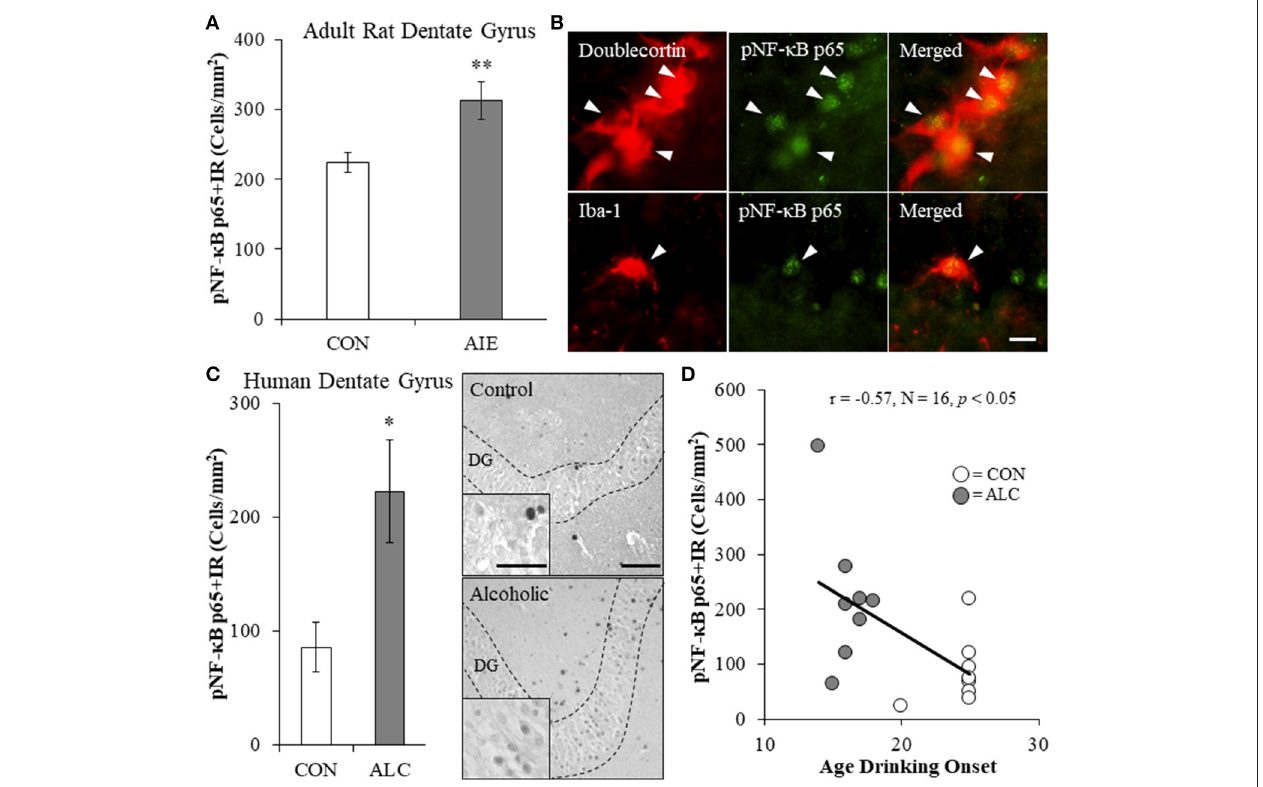
FIGURE 2 | Increased expression of the proinflammatory transcription factor nuclear factor kappa-light-chain-enhancer of activated B cells p65 (phosphorylated [pNF- κ B p65]) in the hippocampal dentate gyrus of adolescent intermittent ethanol (AIE)-treated adult rats and post-mortem human alcoholics. (A) Modified unbiased stereological quantification of pNF- κ B p65 + IR cells revealed a 40% ( ± 12%) increase in the adult (P80) hippocampal dentate gyrus of AIE-treated animals, relative to CONs. (B) High magnification photomicrographs of pNF- κ B p65 (green) colocalization with the immature neuron marker doublecortin and the microglial marker Iba-1 (red) in the hippocampal granule cell layer of an AIE-treated rat. White arrowheads indicate pNF- κ B p65 + IR cells that colocalized with a cellular marker. Scale bar = 10 µ m. (C) pNF- κ B p65 + IR was increased in the post-mortem human alcoholic (ALC) hippocampal dentate gyrus ( n = 8), relative to moderate drinking controls (CON; n = 8). Representative photomicrographs of pNF- κ B p65 + IR in a moderate drinking control and alcoholic subject. Dashed lines indicate outline of the granule cell layer of the hippocampal dentate gyrus. Scale bar = 25 µ m (Insert: 10 µ m). (D) Across subjects, age of drinking onset was negatively correlated with expression of pNF- κ B p65 + IR cells in the hippocampal dentate gyrus ( r = − 0.57, N = 16, p < 0.05). Moderate alcohol drinking controls tended to report a later age of drinking onset (25 ± 1 years of age) relative to individuals that met criteria for alcoholism (17 ± 1 years of age). * p < 0.05, ** p < 0.01, relative to